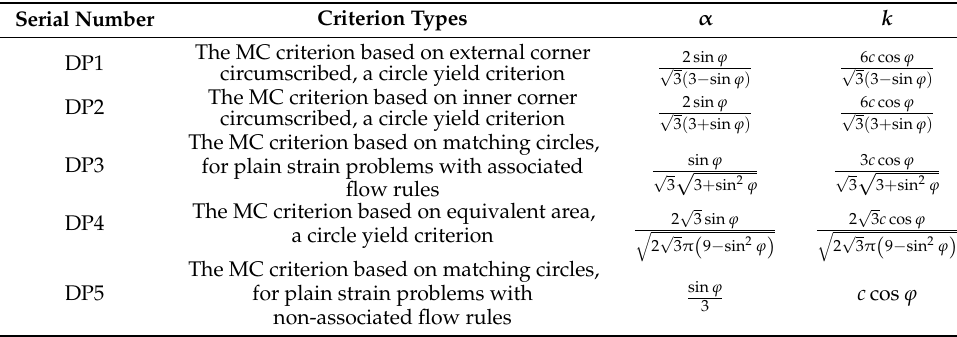
Table 1. Parameter expressions of Drucker–Prager yield